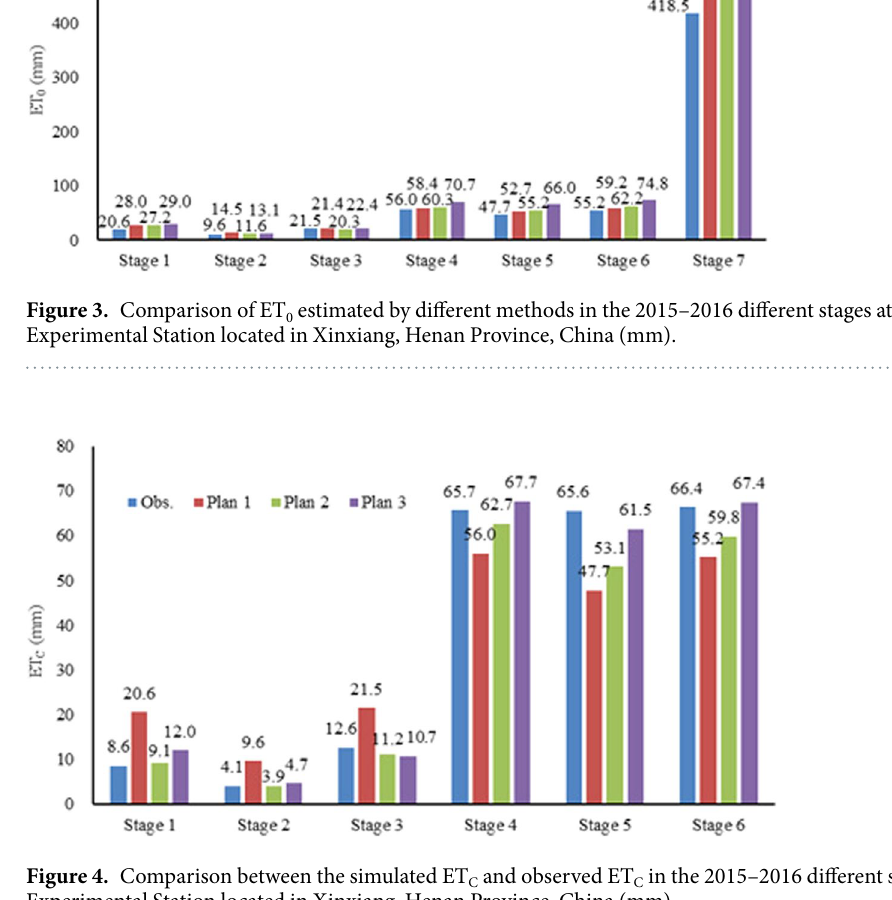
Figure 4. Comparison between the simulated ET C and observed ET C in the 2015–2016 different stages at the Experimental Station located in Xinxiang, Henan Province, China